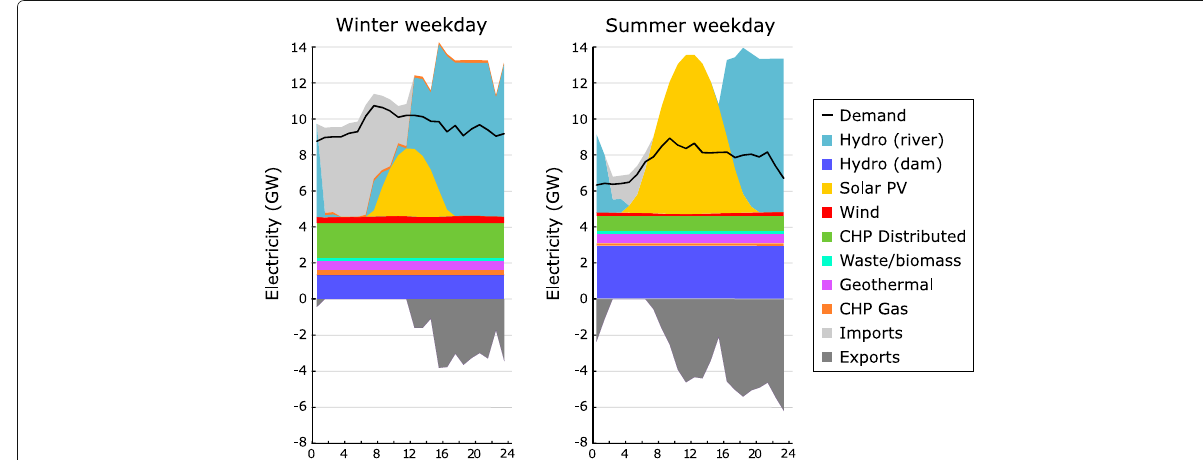
Fig. 5 Electricity supply and use from STEM on typical summer and winter weekdays